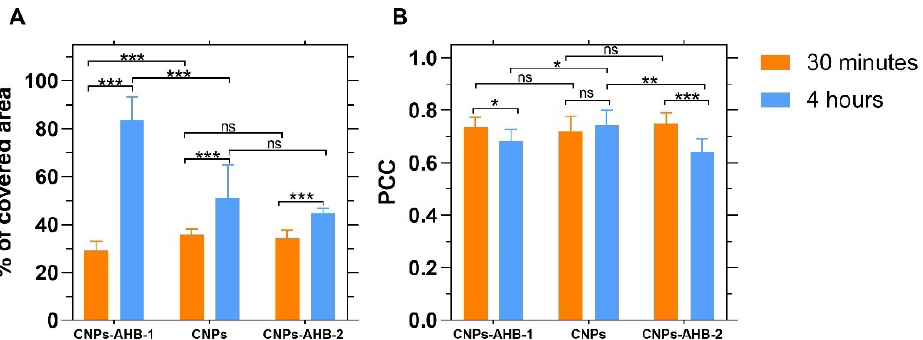
Figure 11. ( A ) Percentage of the covered area by the CNPs in Vero cells. ( B ) Pearson correlation coefficient (PCC) as an indicator of colocalization between CNPs-peptide nanobioconjugates and endosomes labeled with Lysotracker Green ® . In orange, results obtained after 30 min of exposure and in light blue after 4 h. Asterisks represent p values from statistical analysis where * is for p ≤ 0.05, ** for p ≤ 0.01, and *** for p ≤ 0.001.